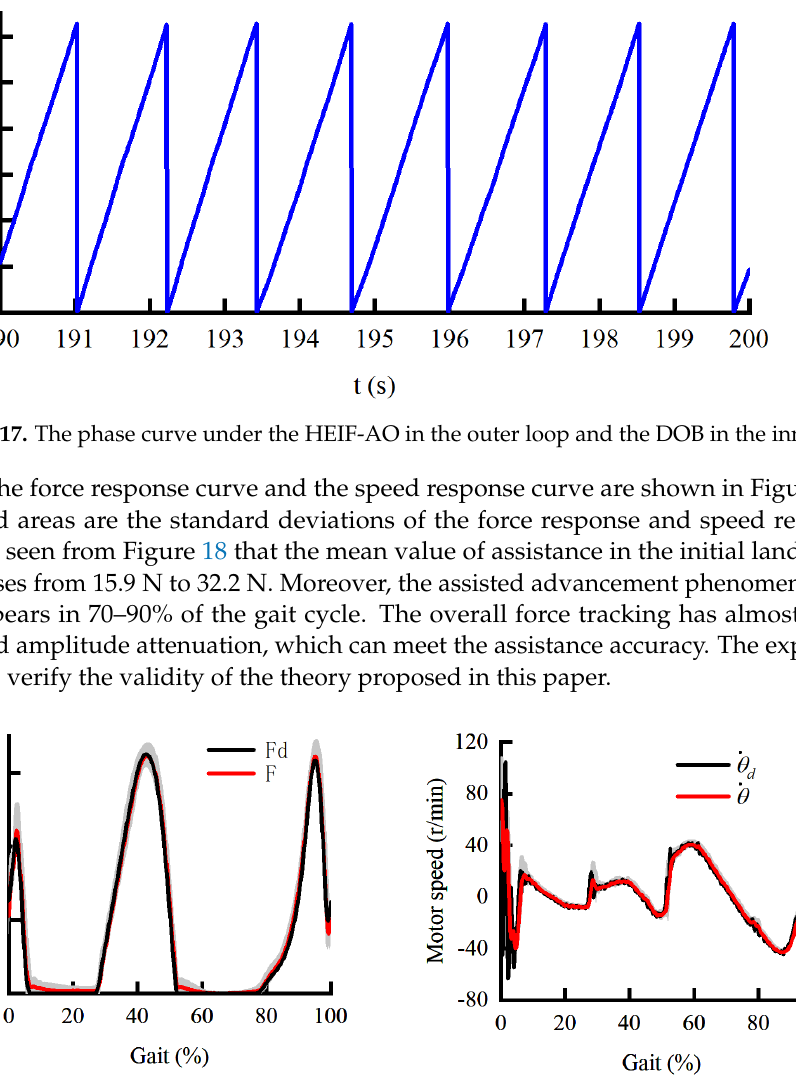
Figure 16. The fundamental frequency curve under the HEIF-AO in the outer loop and the DOB in the inner loop.